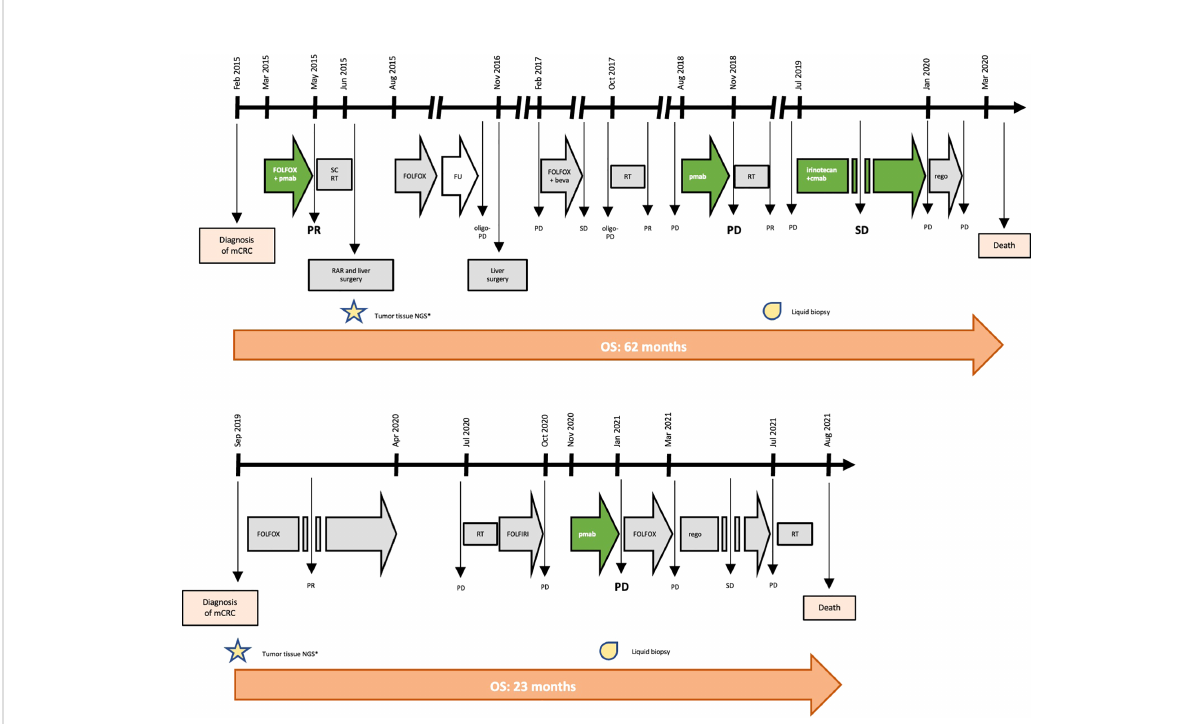
FIGURE 1 Timeline of treatment for patient #1 and #2. Keys: beva, bevacizumab; cmab, cetuximab; FU, follow-up; mCRC, metastatic colorectal cancer; NGS, next genome sequencing; OS, overall survival; pmab, panitumumab; PD, progressive disease; PR, partial response; RAR, rectal anterior resection; rego, regorafenib; RT, radiotherapy; SC, short-course; SD, stable